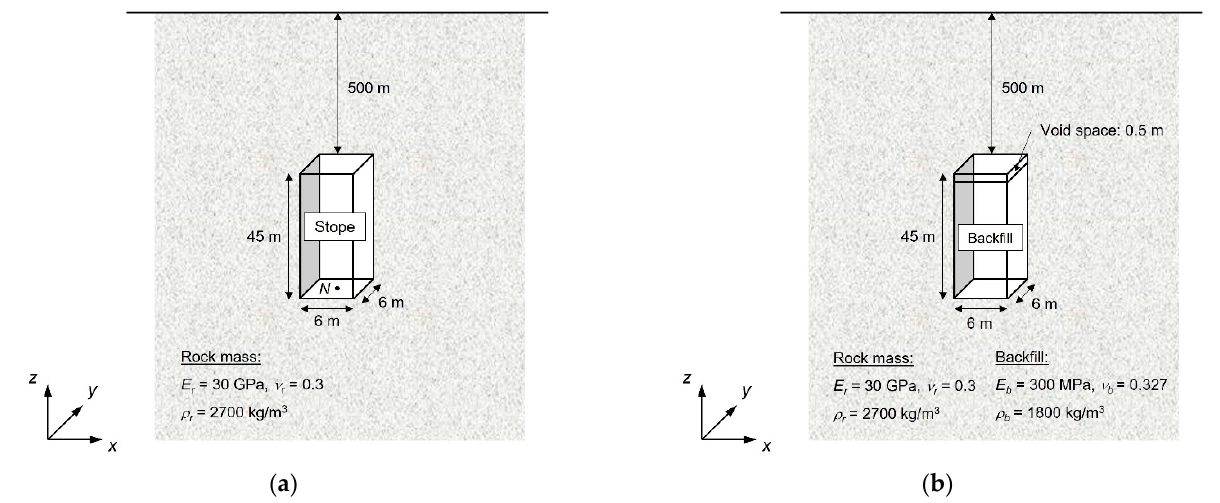
Figure 9. Conceptual model of a three ‐ dimensional vertical stope in rock mass ( a ) before and ( b ) after being backfilled.